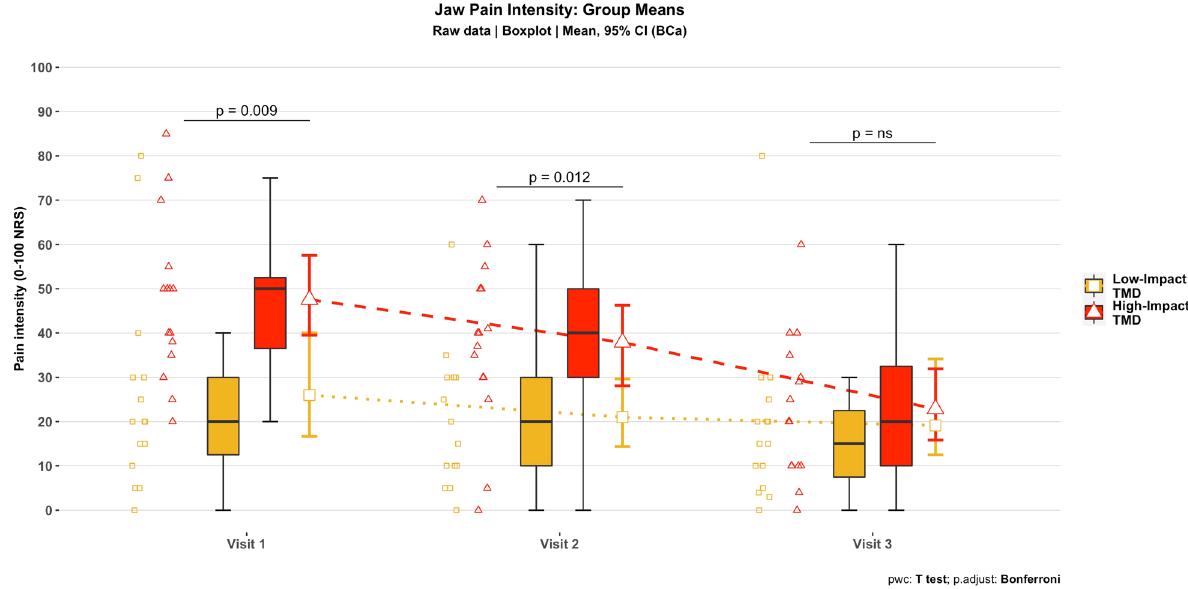
Figure 2. Current jaw pain intensity over time: Group means. Symbols on the left represent raw data points per participant; boxplots show median and interquartile range. Group means are shown with error bars representing their respective bias-corrected and accelerated (BCa) bootstrapped 95% confidence intervals.